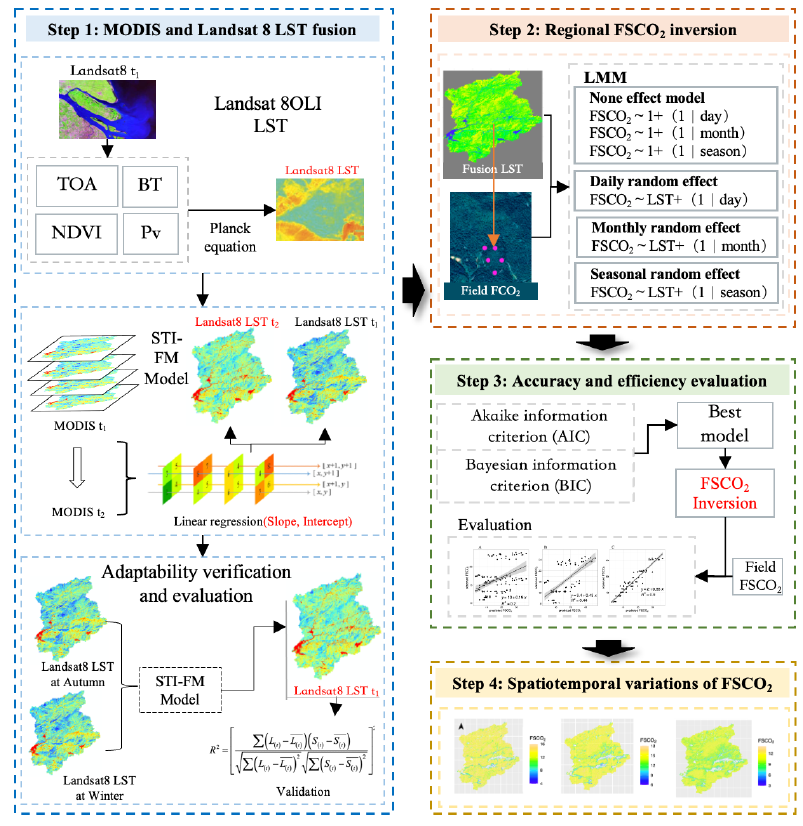
Figure 2. The flowchart of the